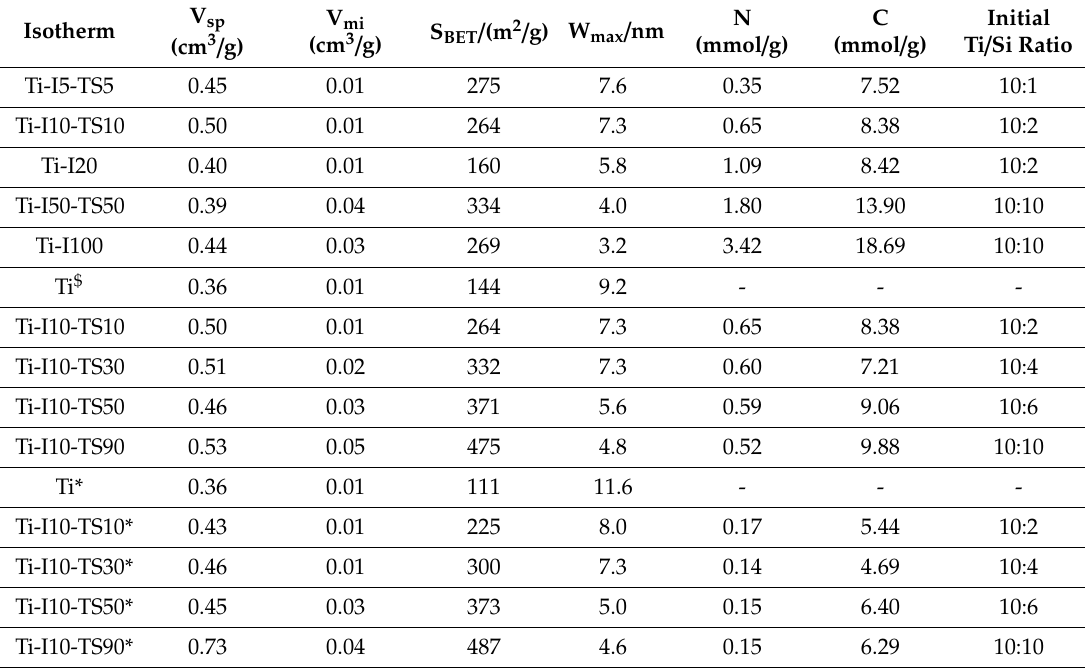
Table 2. Structural parameters for the studied Ti-MO